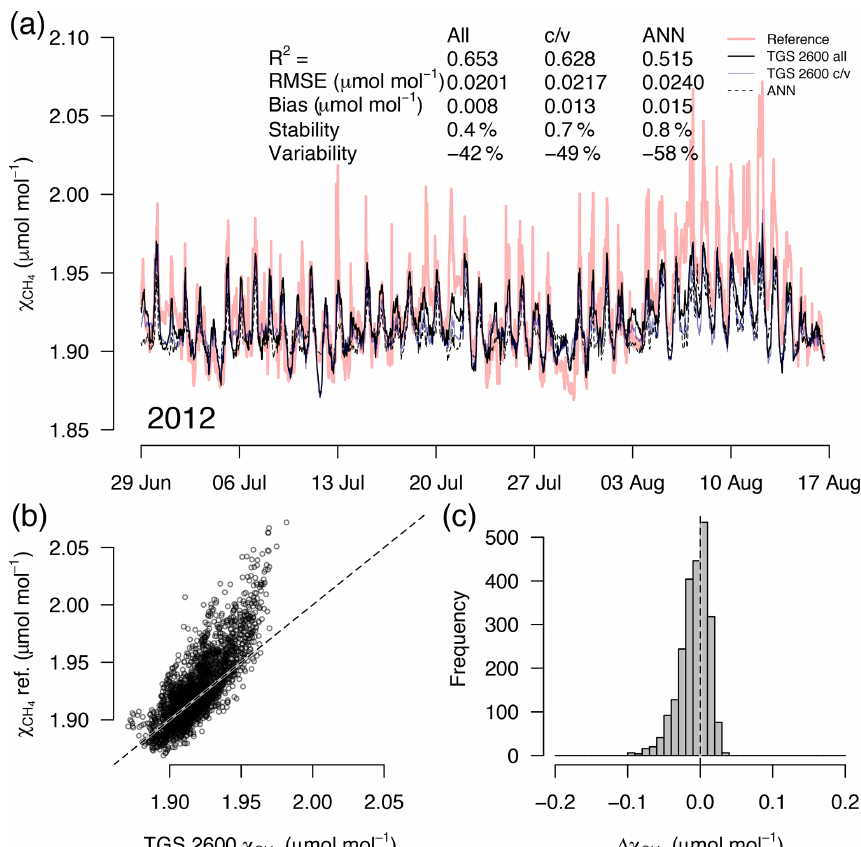
Figure 5. (a) Time series of TGS 1-derived CH 4 during a 7-week snow- and ice-free period in the first year of the long-term deployment (2012), (b) correlation with reference mole fraction, and (c) residuals (TGS 2600 all minus the reference) of 30min averaged measurements. Thin solid lines in (a) show the result when all data are used with Eq. (2), reference mole fraction is shown with a red bold line, c/v shows an alternative fit from splitting the available data into a calibration and a validation part, and the dashed line shows the performance of an artificial neural network (ANN) fit. This example belongs to the validation period of the TGS 2600 c/v and ANN